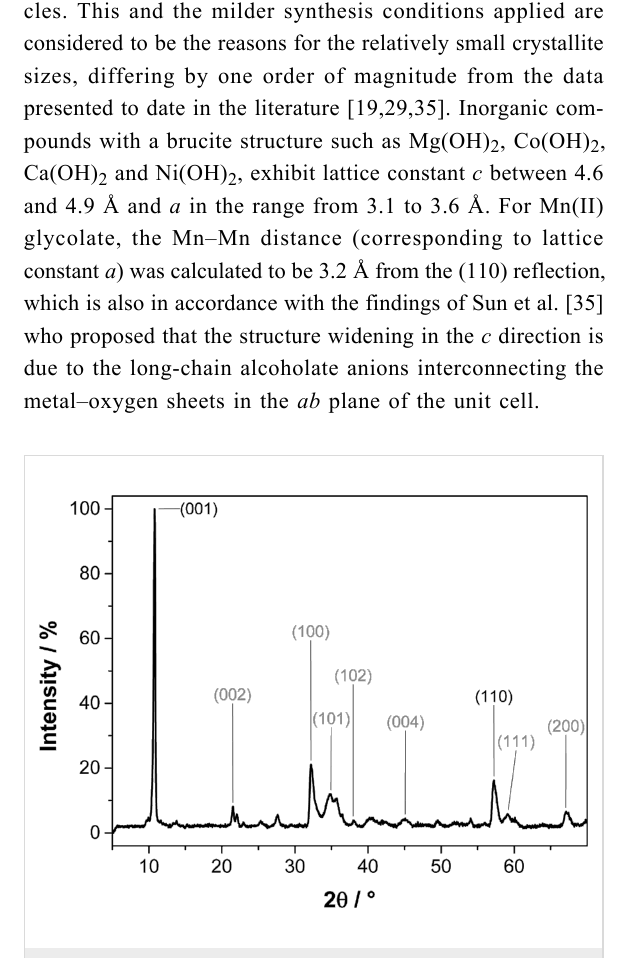
Figure 1: Powder XRD pattern of Mn(II) glycolate particles synthe- sized for 7 h; literature assignments [35] (black) and calculated reflec- tion assignments (grey) are given for the brucite structure exhibiting lattice constants of a = b = 3.2 Å and c = 8.2